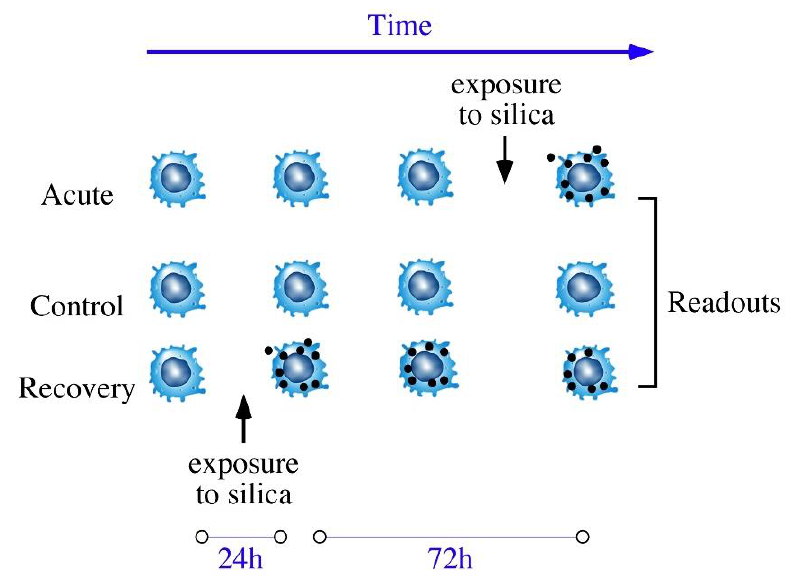
Figure 1. Schematic representation of the exposure schemes used in the study.